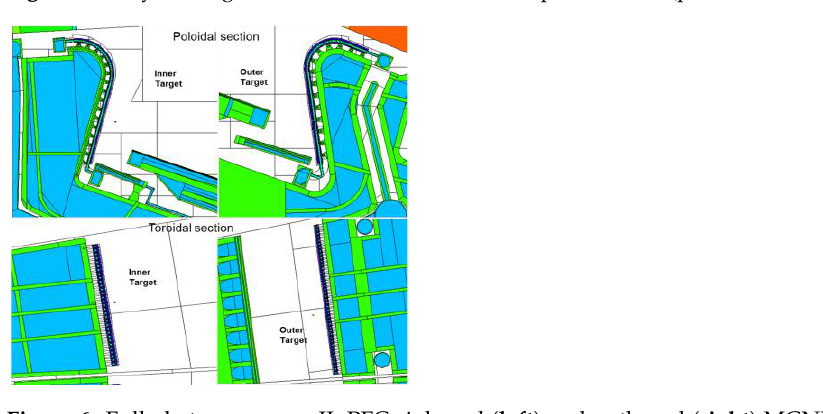
Figure 7. Inboard ( left ) and outboard ( right ) targets (CAD model [27]), highlighting the external sides, the innermost side with the point C on the inboard baffle region and the horizontal and ver- tical abscissa along the toroidal and poloidal direction, respectively. Note that the colors in Figures 4 – 6 are representative of the material mixtures as- signed to every geometrical cell of the MCNP models when these are observed through the MCNP geometry viewer. Therefore, these colors are shown only for a symbolic scope, not having any specific meaning. The pre-processing and preparation of the IL CAD model has been performed by means of the 3D modeling software ANSYS SpaceClaim 2019 [44] in order to generate a CAD model suitable for neutronic analyses. The simplified CAD model has been converted into the equivalent MCNP geometrical representation using the CAD-to-MCNP interface of SuperMC [45]. To create a correct coupling between the neutronics model of the PFC and that of the cassette body and to further simplify the model integration phase, it has been necessary to integrate 31 (inboard) and 43 (outboard) CuCrZr pipes in the DEMO divertor 2019 MCNP model, which is shown in Figures 5 and 6. An example of a full outer target array of 43 PFCs is shown in Figure 8 [46]. Figure 8. 3D view of a full outer target array of 43 PFCs ( left ) and individual PFCs set ( right ) [46].